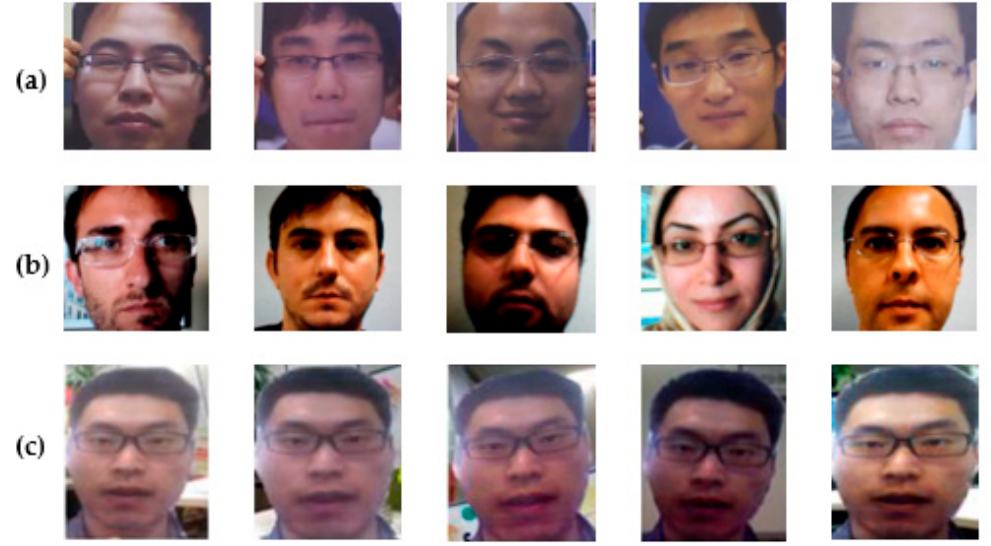
Figure 1. Fake image examples of public face databases: ( a ) printed photo attack samples; ( b ) replay video attack samples; ( c ) 3D facial mask attack samples.